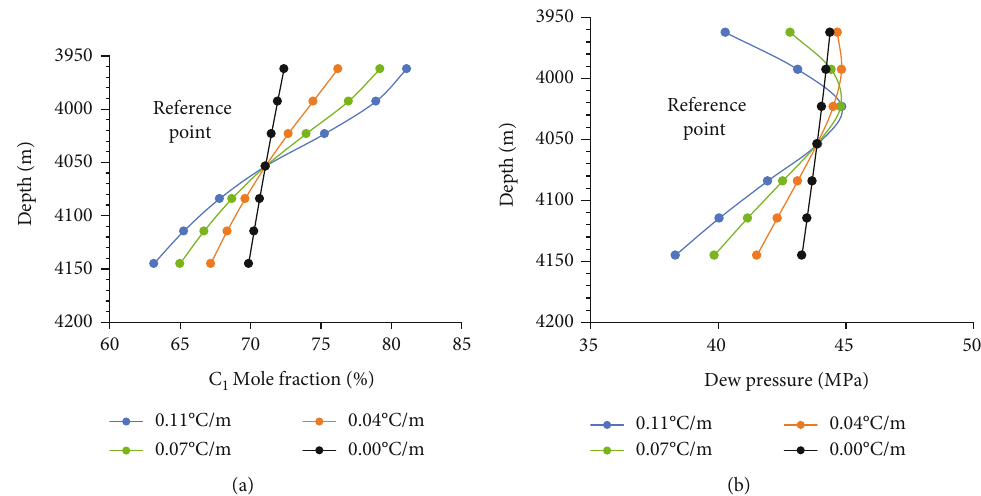
Figure 1: (a) E ff ect of geothermal gradient on compositional gradient. (b) E ff ect of geothermal gradient on dew point